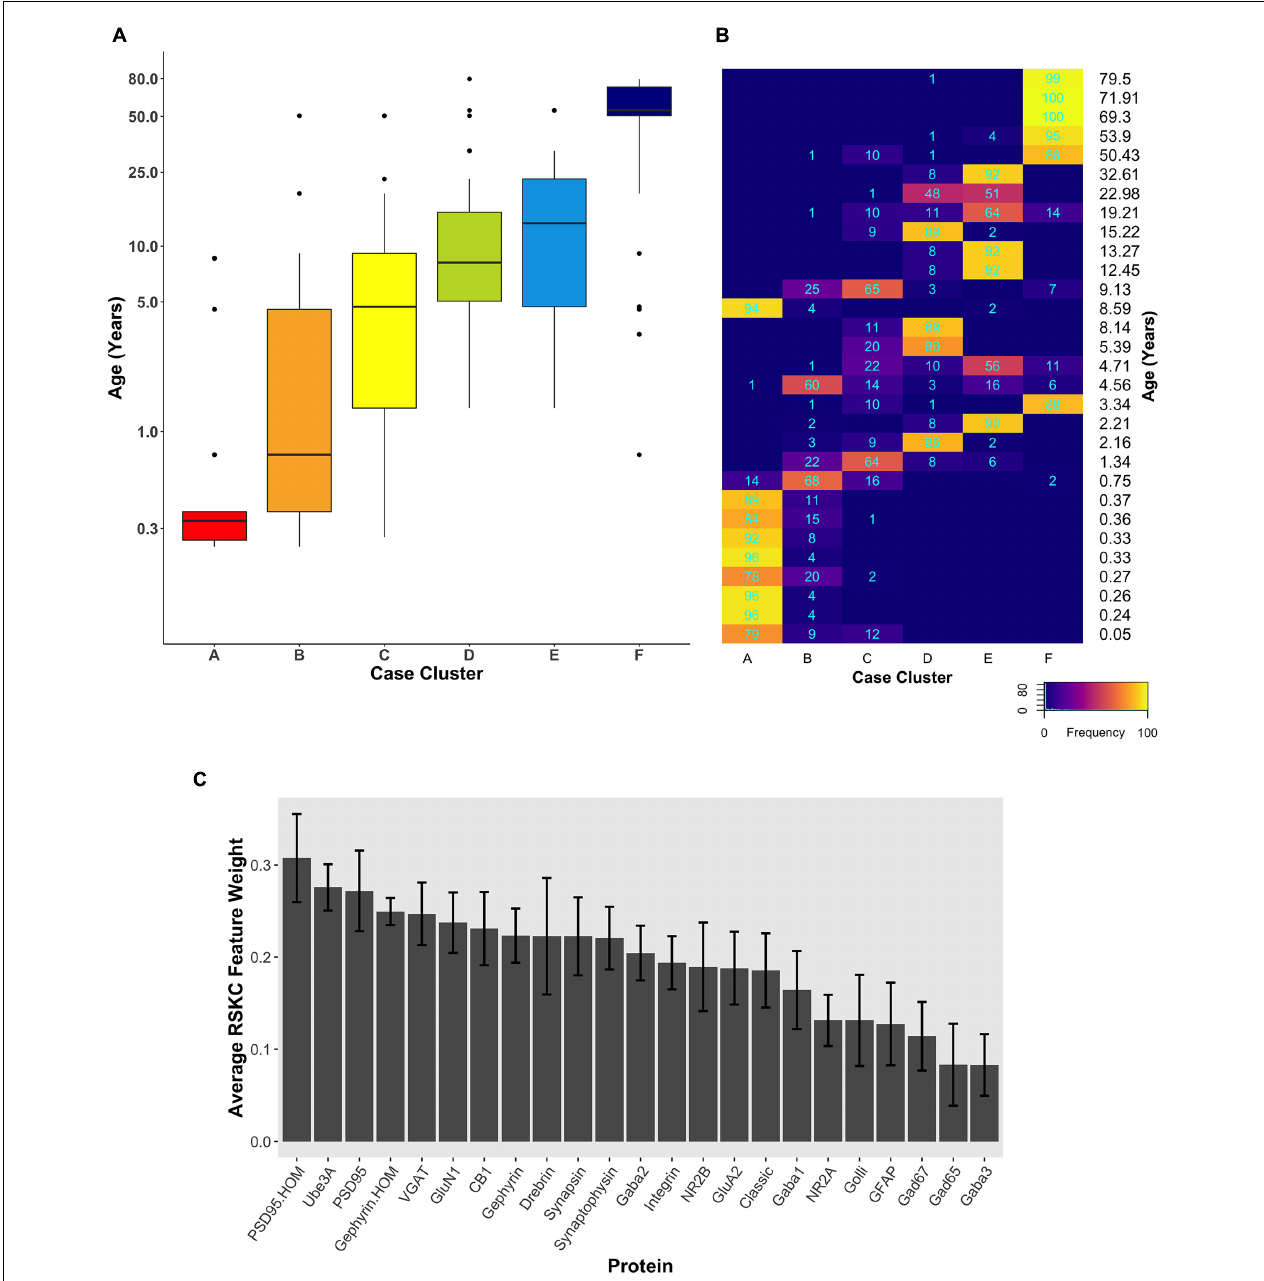
FIGURE 6 | Robust, age-related clustering of 23 synaptic proteins for 100 iterations. (A) Expression data from 23 synaptic proteins was used to identify six case clusters. The cluster designation of each case over 100 iterations of RSKC was used to visualize the distribution of case ages (in years). Boxplots denote the median and interquartile range of ages in each cluster, and points denote outliers. (B) Heatmap visualizing the number of times each case was assigned to each cluster over 100 iterations of RSKC. (C) The average RSKC feature weight for each of the proteins from the 100